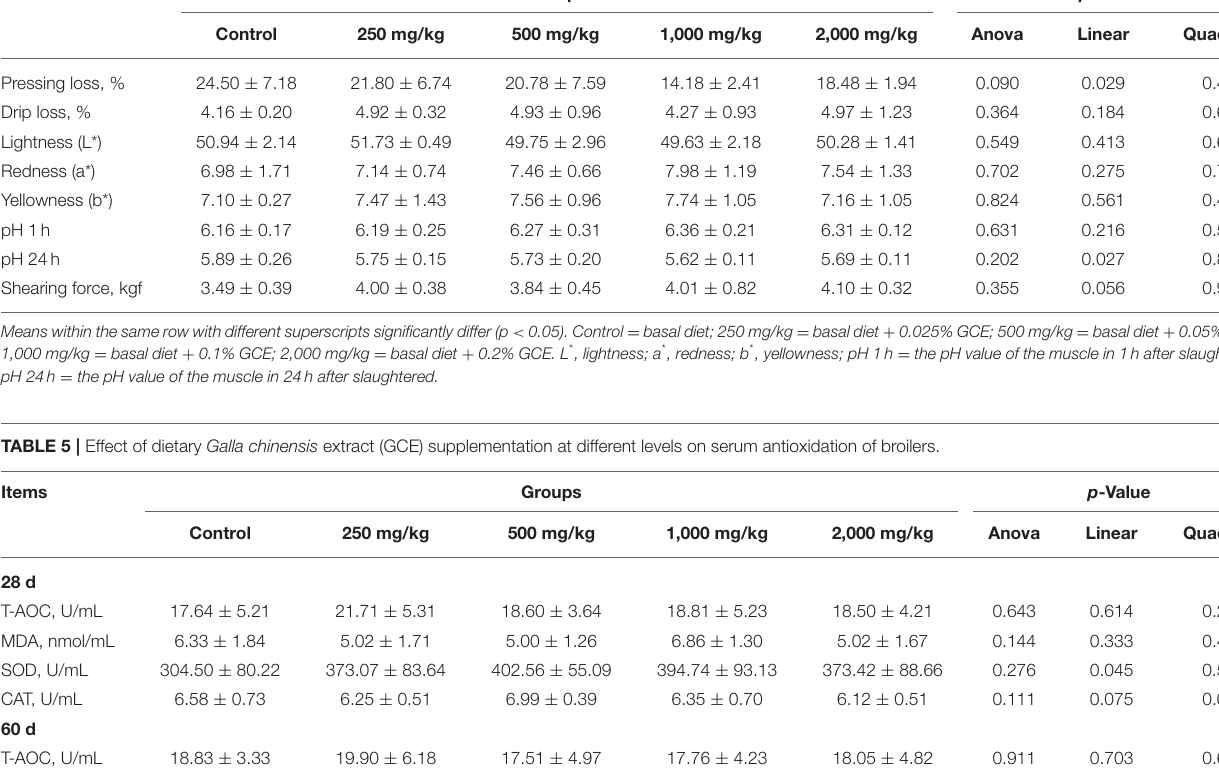
Linear Quadratic